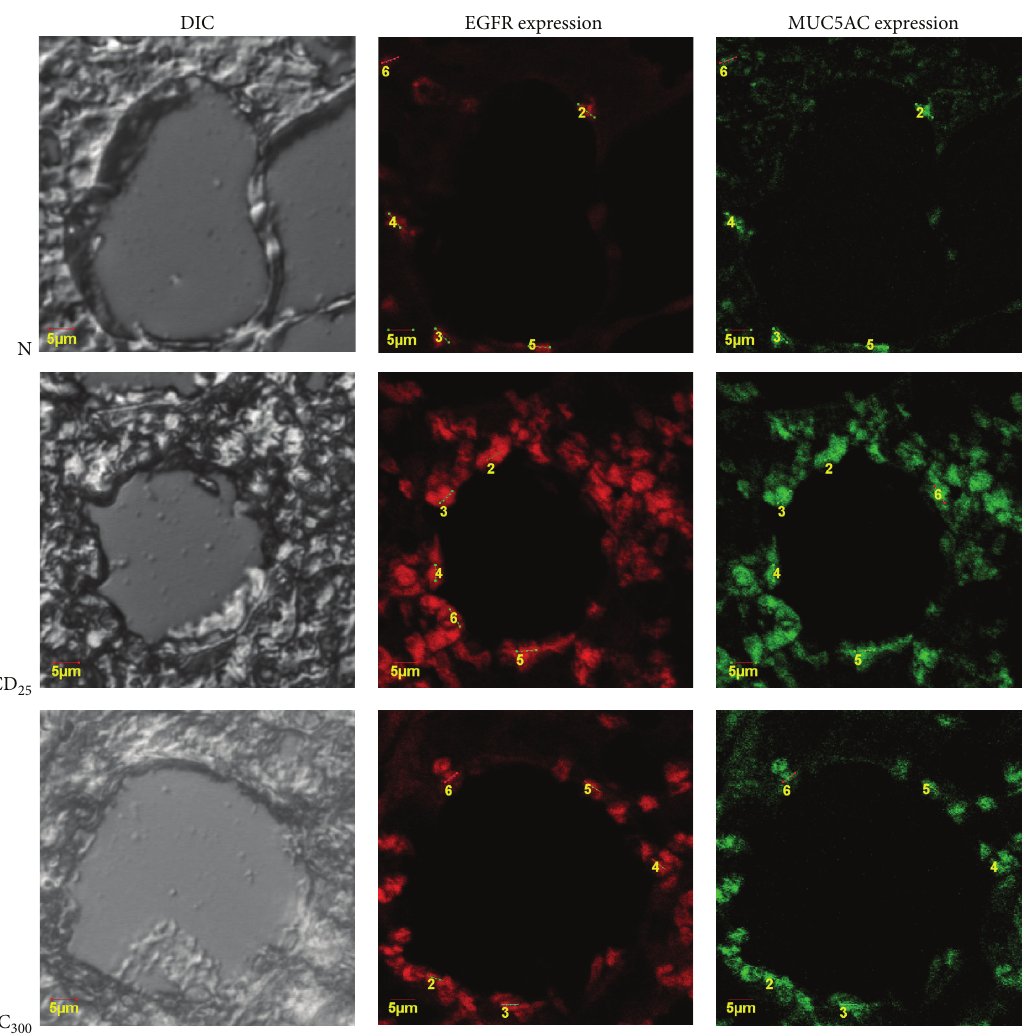
Figure 7: Representative immunofluorescence with anti-EGFR and anti-MUC5AC antibodies for determination of the lung EGFR and MUC5AC expressions in rats. These expressions were analyzed by counting fluorescent intensity of cells (in arbitrary units (AU)) in five random high-power (×400) microscope fields. The fluorescent images were recorded under a confocal laser scanning microscope. Cells were shown EGFR positive ( red fluorescent ) and MUC5AC positive ( green fluorescent ). Differential interference contrast (DIC); non-exposure group (N); group exposed to coal dust at dose of 25 mg/m 3 (CD 25 ); group supplemented with the ethanolic extract of E. cottonii at dose of 300 mg/kgBW (EC 300